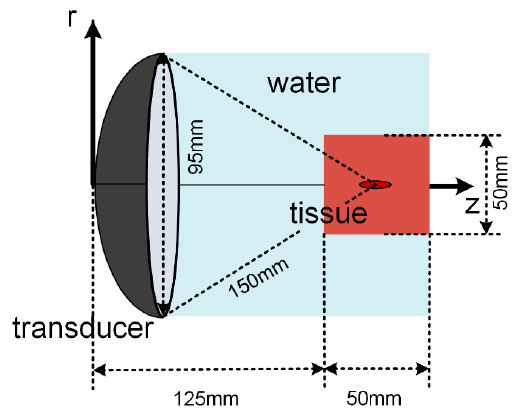
Figure 1. Schematic diagram of the model used in the simulation.